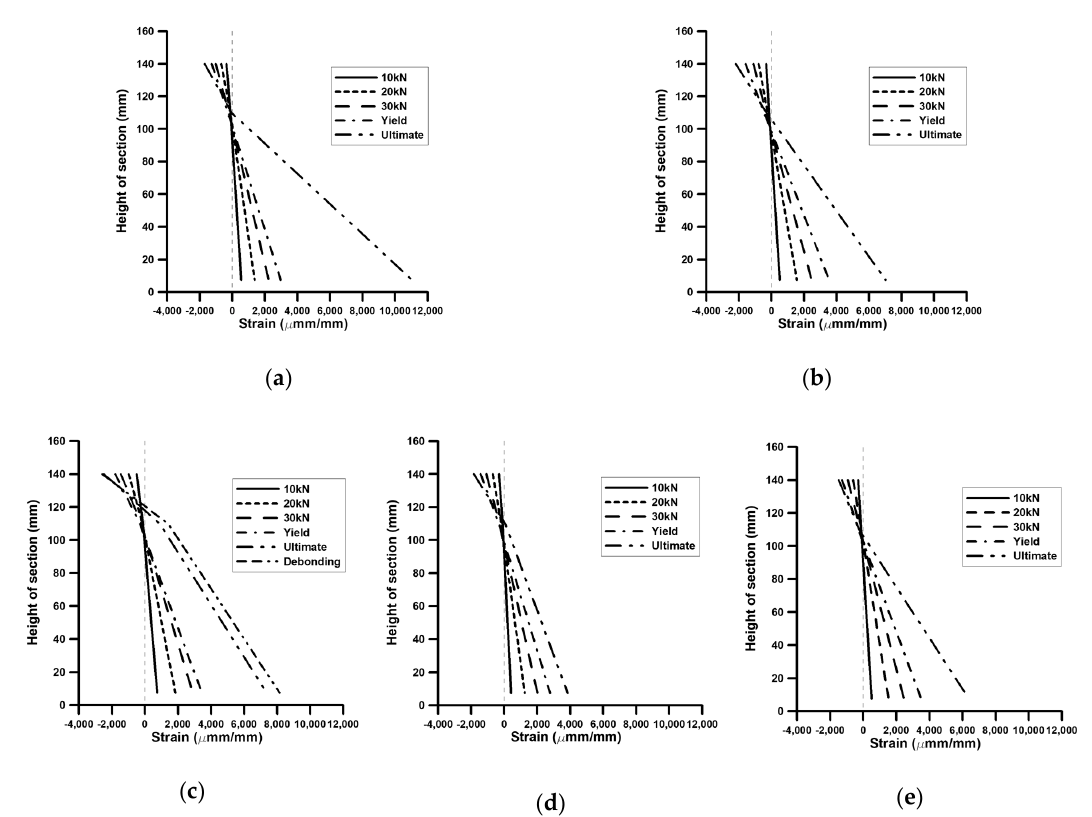
Figure 12. Strain distribution of different load levels: ( a ) T1M; ( b ) T3; ( c ) T2; ( d ) T2AP; ( e ) T2E.